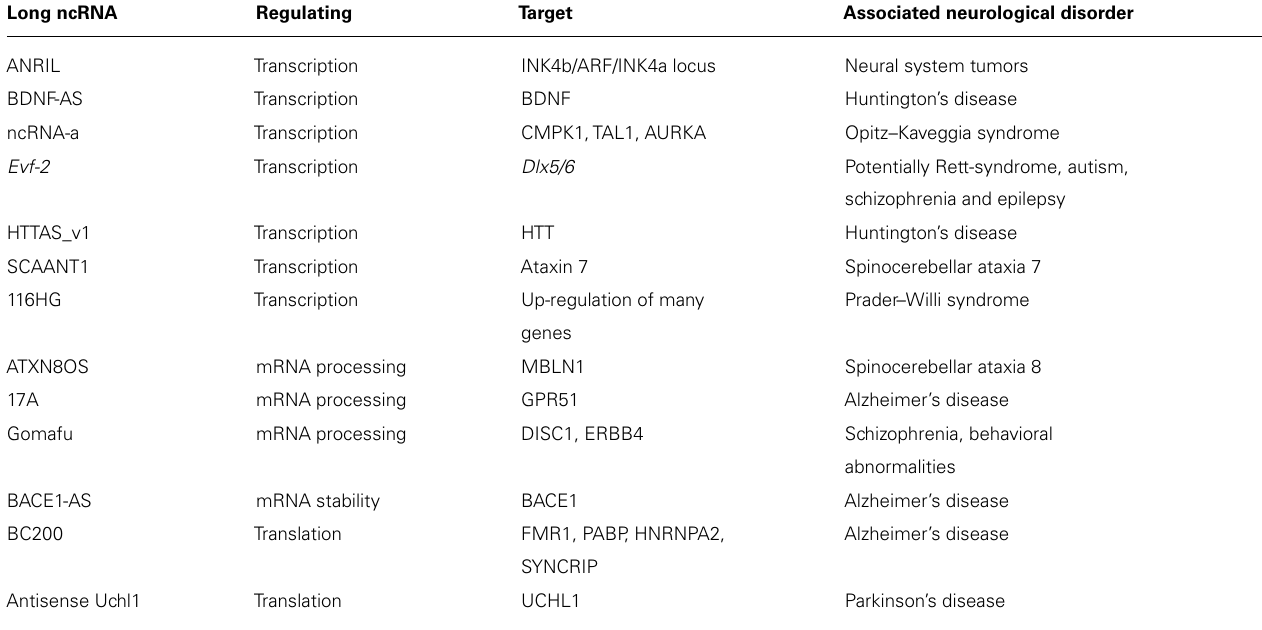
Table 1 | Long ncRNAs involved in neurological